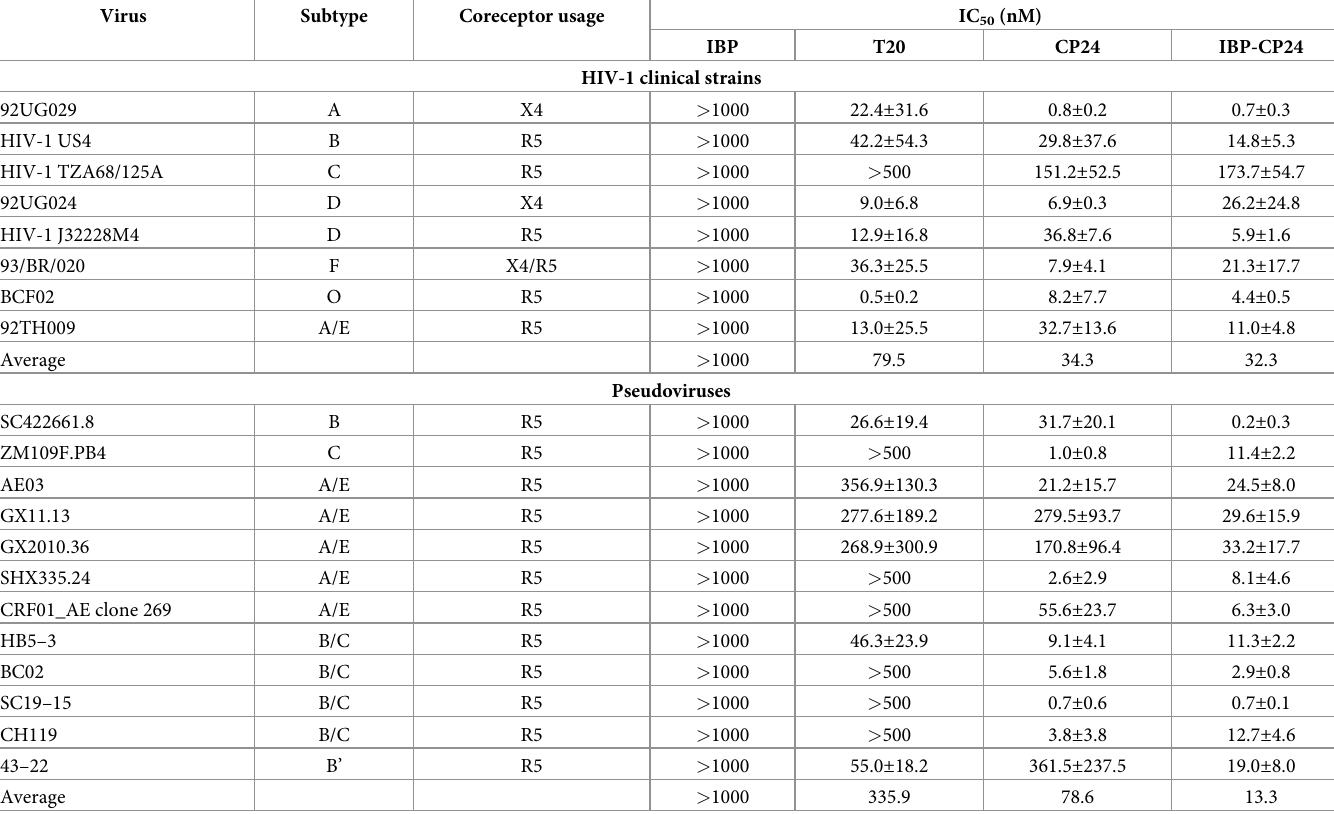
Table 3. Inhibitory activity of IBP, T20, CP24, and IBP-CP24 against HIV-1 clinical strains and pseudovirus. Virus